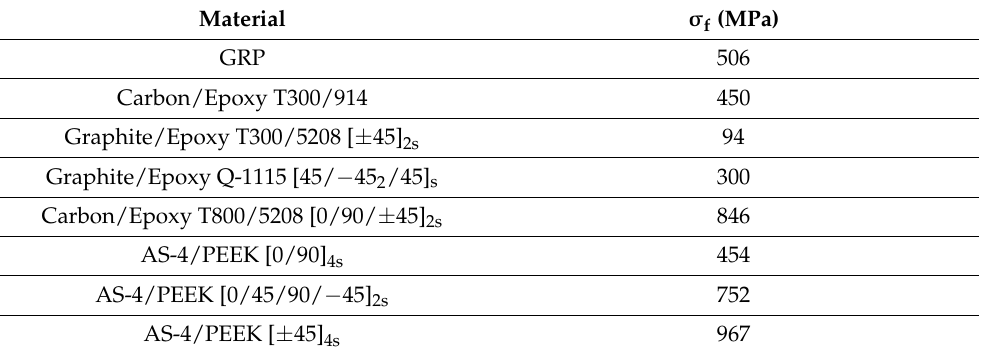
Figure 7. Analytical prediction of the remaining life versus consumed life for the case of carbon/epoxy (T800/5208). The experimental data points are taken from Ref. [41]. Table 1. List of the composite materials under investigation, including the corresponding fatigue strength coe ffi cient values.